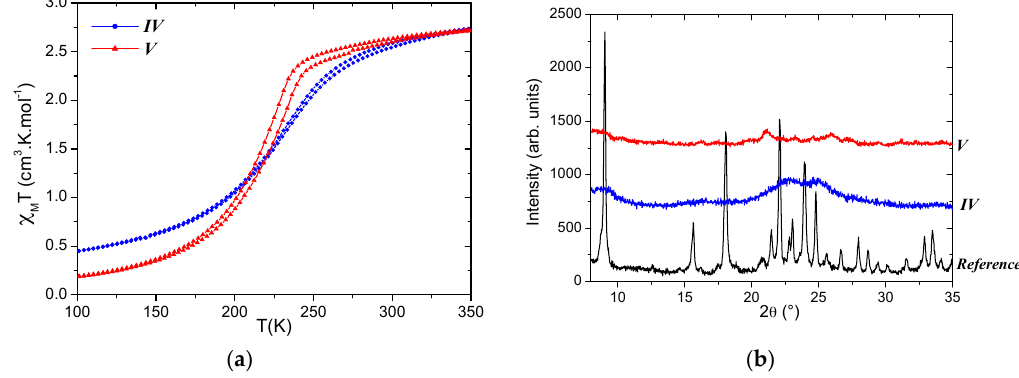
Figure 5. Physical characterizations of batches IV (blue) and V (red) showing ( a ) χ M T as a function of temperature and ( b ) the PXRD patterns, including the reference one for [Fe(NH 2 trz) 3 ](BF 4 ) 2 . The latter corresponds to the hexagonal unit-cell with a = b = 19.644(1) Å and c = 7.726(1) Å [23]. Table 2. Elemental analysis (CHN) for batches IV and V with expected values for [Fe(NH 2 trz) 3 ](BF 4 ) 2 . Sample % N % C